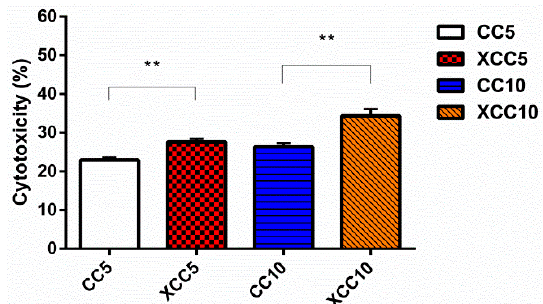
Figure 6. Cell cytotoxicity induced by CaCO 3 :Ce under X-ray irradiation (t-test, mean ± SD, n = 6, **: p -value < 0.01).